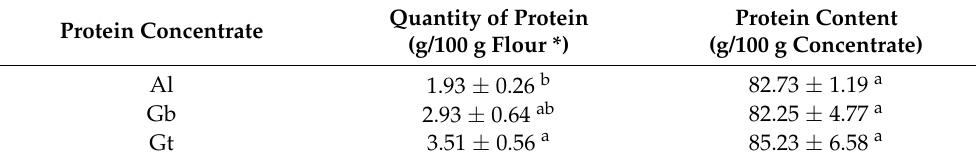
Values are shown as mean ± standard deviation of triplicate determinations. Means with different superscripts, in the same column, are significantly different ( p < 0.05). Al = Albumin; Gb = Globulin; Gt = Glutelin. * Defatted flour, without alkaloids and phenols.